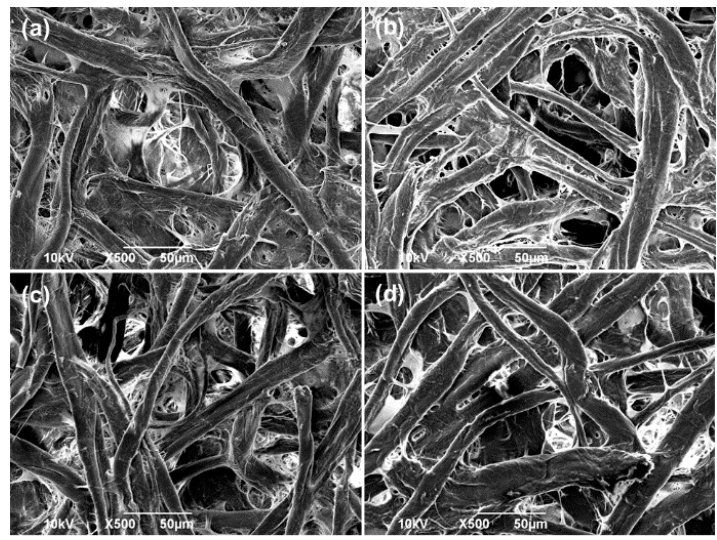
Figure 3. Scanning electron microscopy (SEM) surface analysis of ( a ) untreated, ( b ) PFW treated, ( c ) PDMS- b -PEO treated, and ( d ) PFW /PDMS- b -PEO treated FP samples. ( c ) PDMS- b -PEO treated, and ( d ) PFW /PDMS- b -PEO treated FP